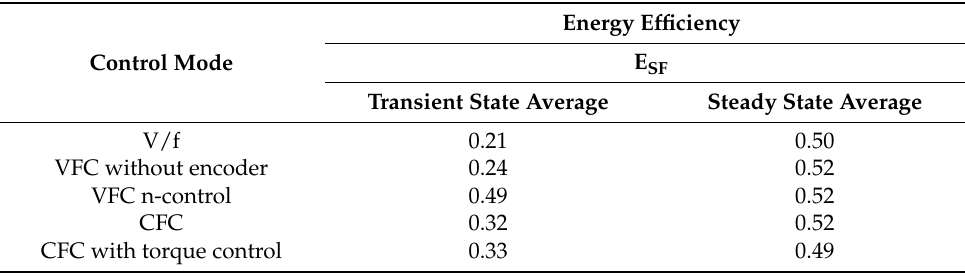
Table 17. Characteristics of the energy efficiency E SF in the steady state (with the external load).